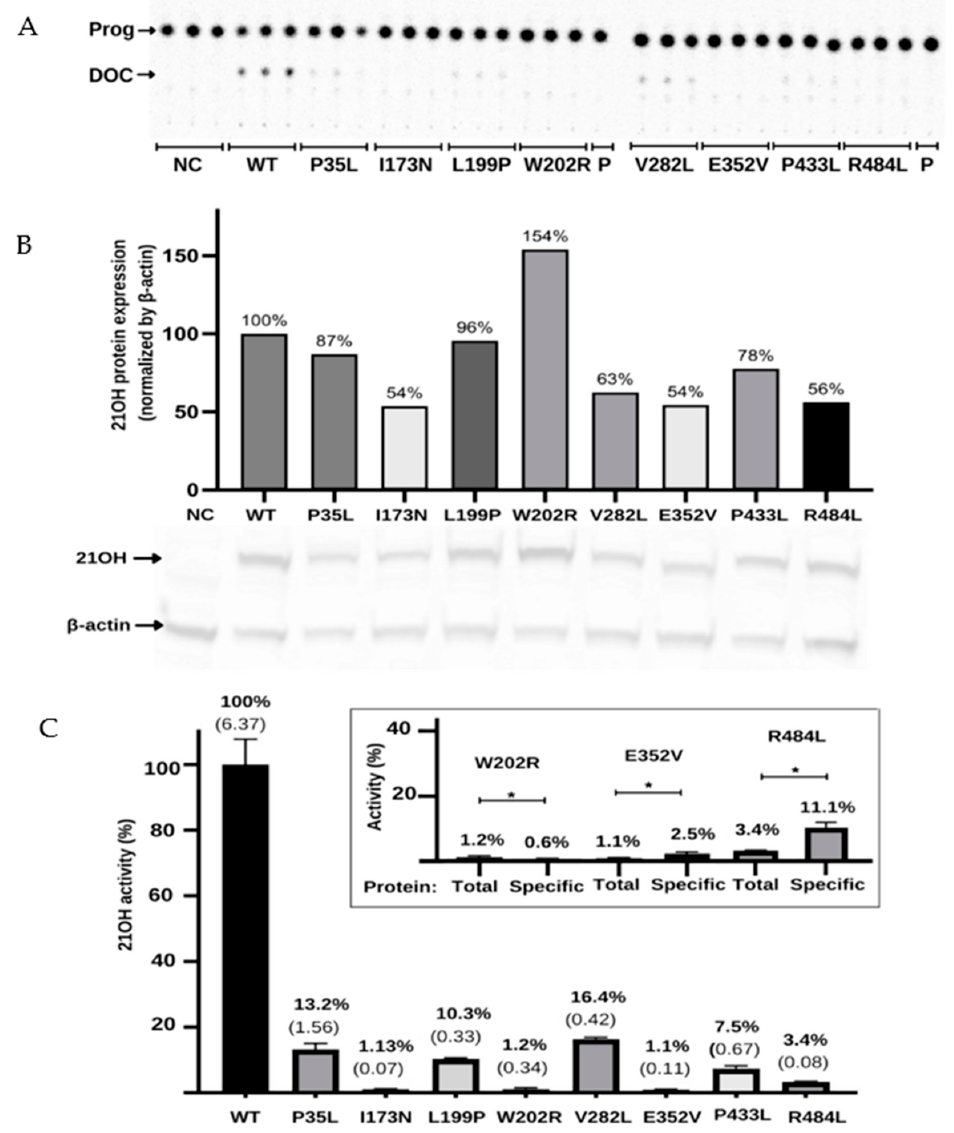
Figure 5. Functional characterization of the variants in the CYP21A2 gene by relative steroid conversion of progesterone (Prog; P) to 11-deoxyprogesterone (DOC). The activity was obtained using 21OH wild-type (WT) and mutated expressed in the HEK293t cell where we measured the steroid conversion by the percentage of radioactivity in DOC to the whole sample. ( A ) Thin-layer chromatography (TLC) shows that all variants reduce the activity of 21-hydroxylase (21OH). ( B ) Semiquantitative 21OH expression level obtained by western blot with anti-flag antibody for the 21OH (53 KDa) and normalized by β -actin (42 KDa) expression with anti- β -actin antibody. Negative control (NC) presents the basal HEK293 cells. ( C ) The 21OH activity expressed accordingly with TLC spots densitometry and related to the WT. Bars represent the standard error from three samples. Inside the box is plotted the activity (total) and the specific activity (specific) of the three variants that showed statistically significant difference (* p < 0.05) between these values. The specific activity was obtained by dividing the enzyme activity by the 21OH protein estimated by western blot. All results were analyzed on GraphPad software. * p value < 0.05